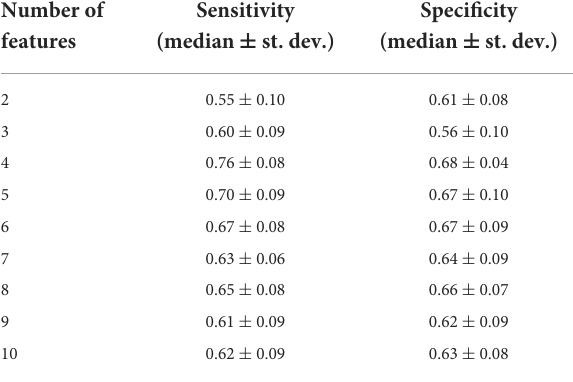
TABLE 2 The sensitivity and specificity of discriminating patients with AD from healthy controls. Number of features